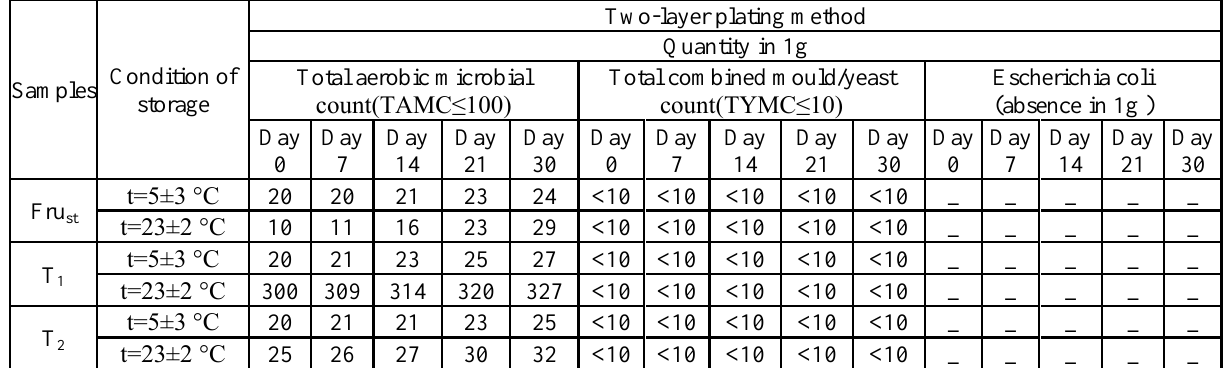
Results from microbiological